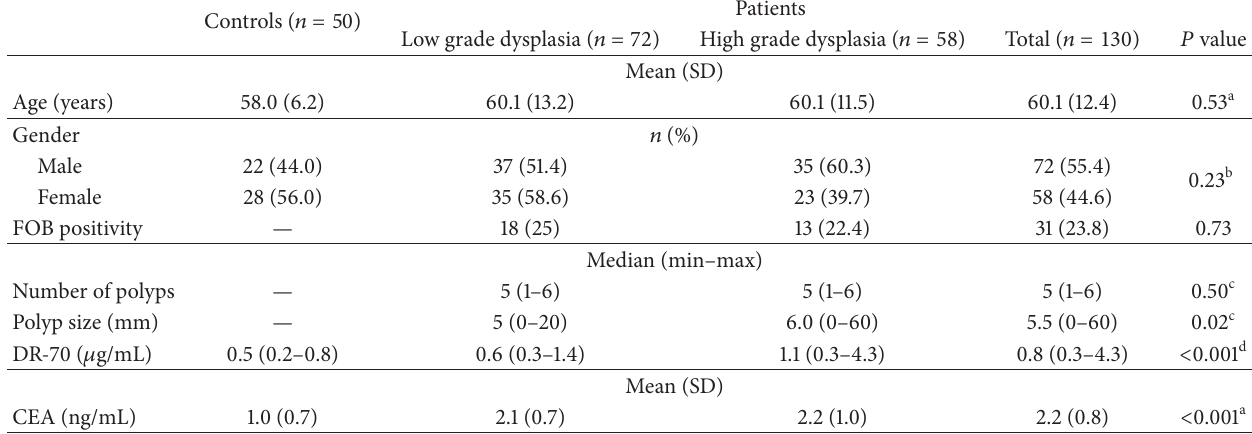
Table 1: Comparisons of demographic characteristics and clinical parameters in the control, low grade dysplasia, and high grade dysplasia groups.